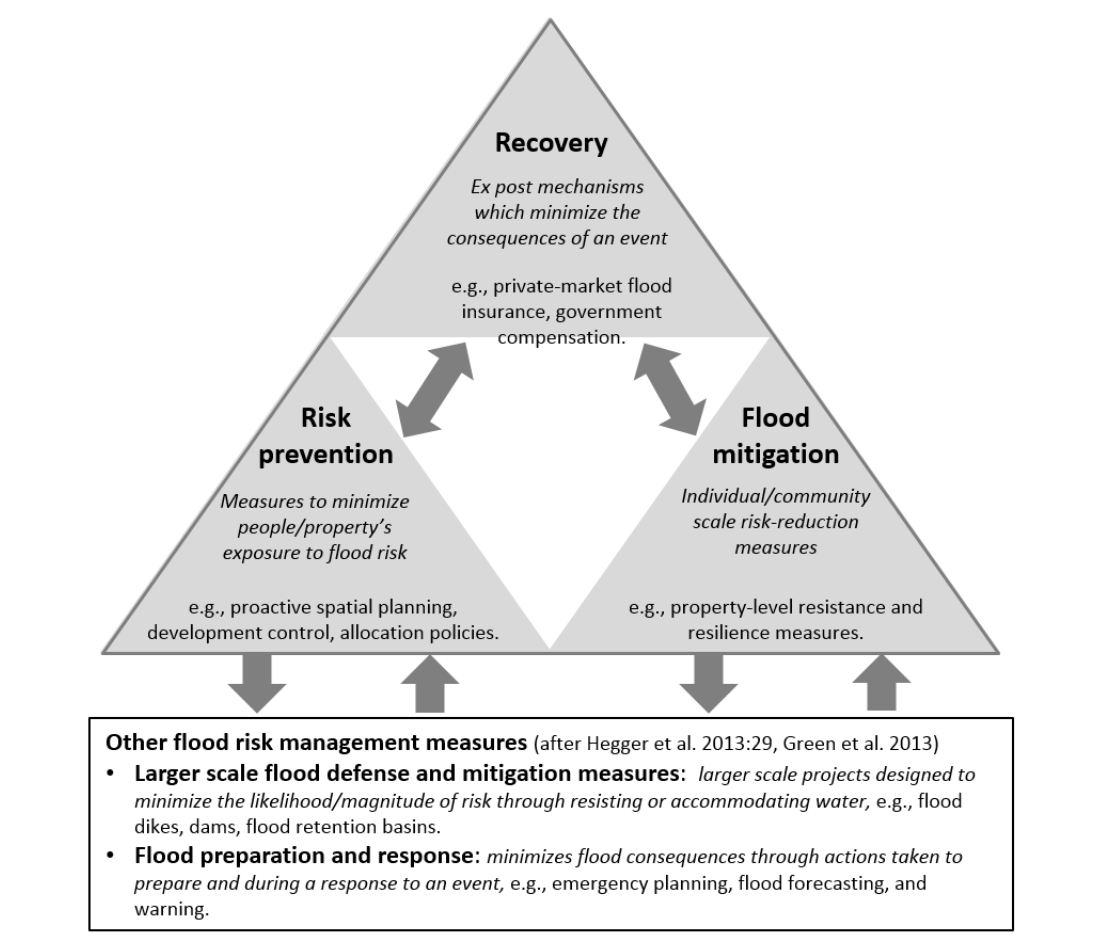
Fig. 1 . The linkage between flood risk management